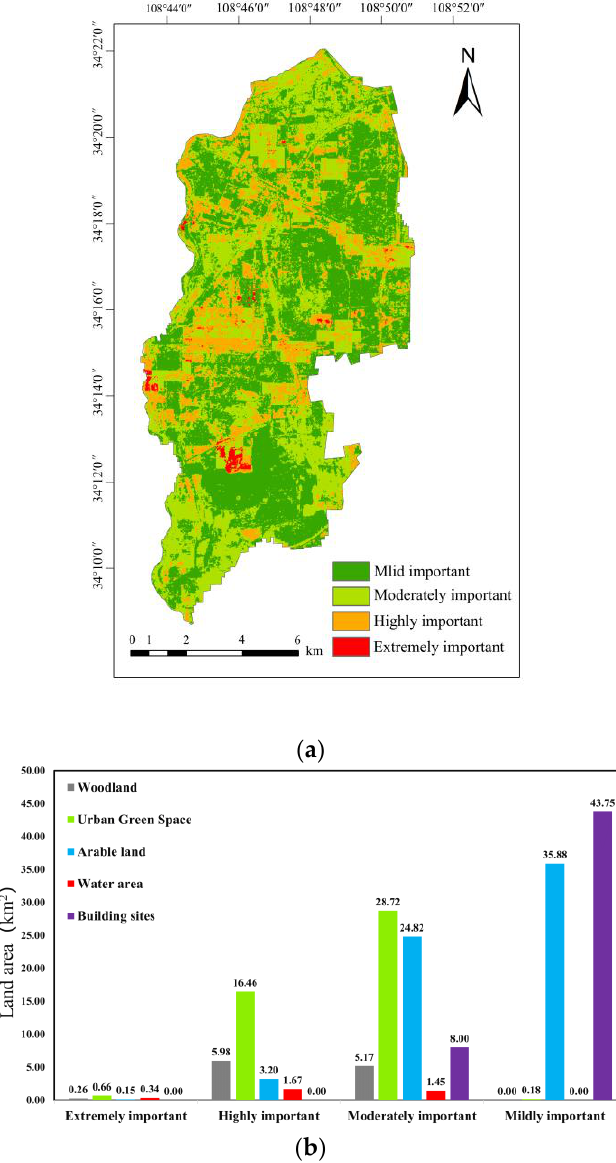
Figure 7. Evaluation of ecological demand intensity. ( a ) The evaluation result of the importance of ecological demand intensity; ( b ) land analysis.